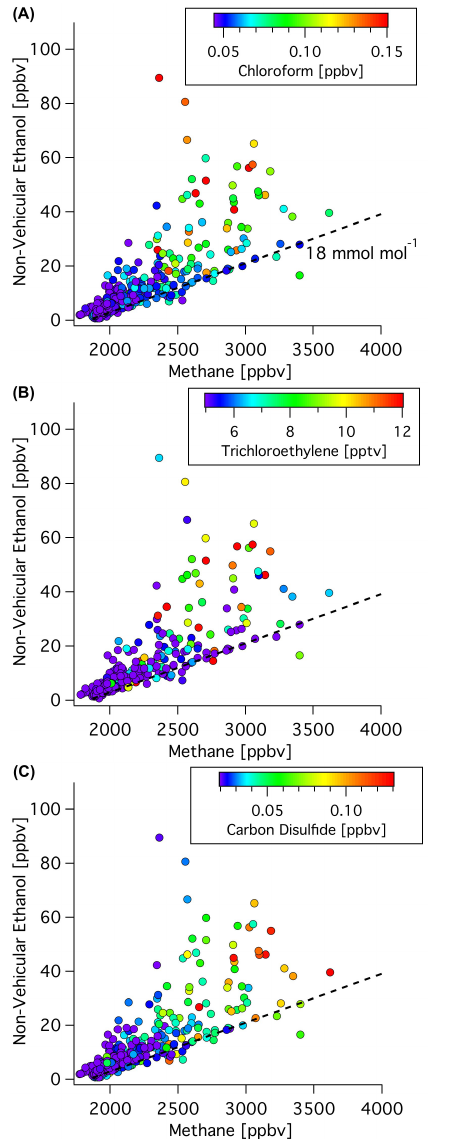
1171 Figure 7: Observations of non-vehicular ethanol vs. methane are correlated and shown with the 1172 Figure 7. Observations of non-vehicular ethanol vs. methane are inferred emission ratio from dairy operations. Enhancements of ethanol from another source than 1173 correlated and shown with the inferred emission ratio from dairy the dominant source of methane and ethanol are shown by enhancements in (A) chloroform, (B) 1174 operations. Enhancements of ethanol from a source other than the trichloroethylene, and (C) carbon disulfide. No major enhancements of methane are observed 1175 dominant source of methane and ethanol are shown by enhance- beyond the inferred slope with non-vehicular ethanol. 1176 ments in (A) chloroform, (B) trichloroethylene, and (C) carbon 1177 disulfide. No major enhancements of methane are observed beyond the inferred slope with non-vehicular ethanol.